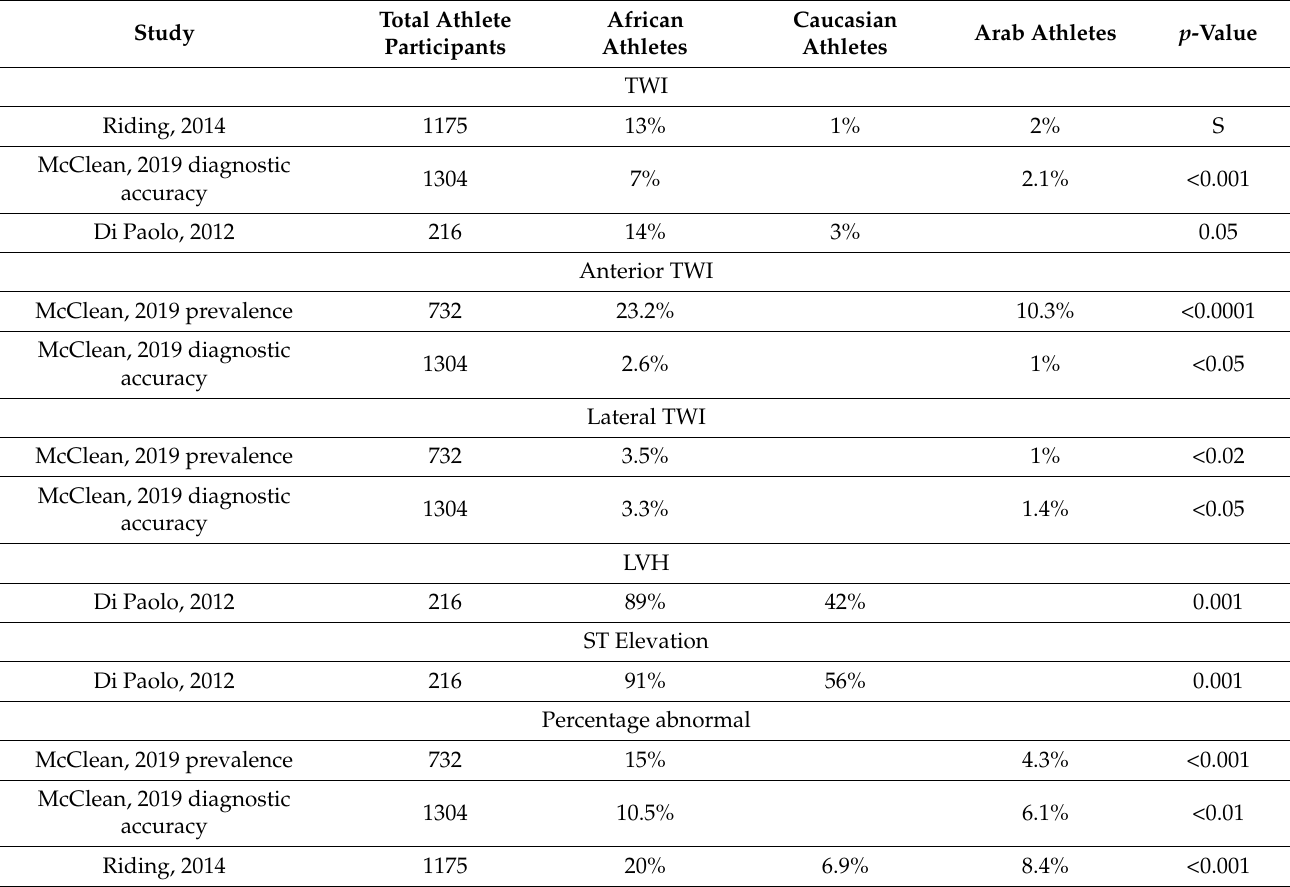
Table 3. Proportions of ECG changes in African athletes compared to